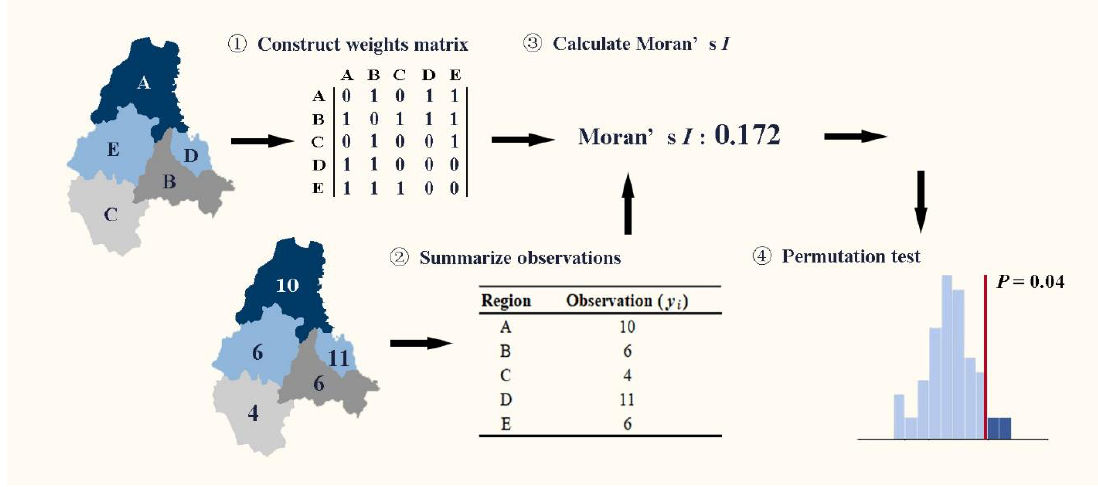
Figure 4. I llustration of the significance test based on Moran’s I. Figure 4. Illustration of the significance test based on Moran’s